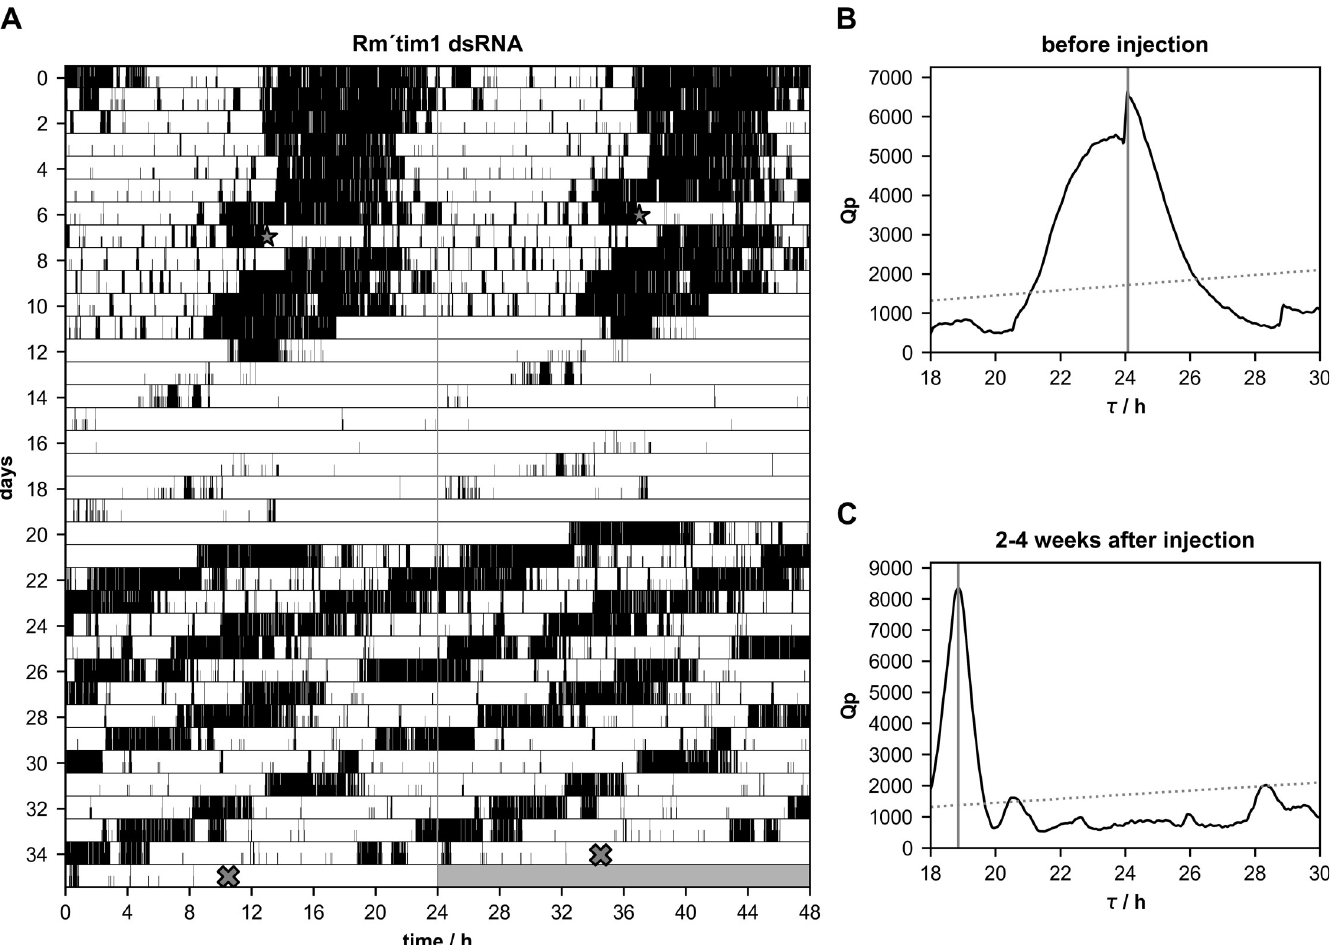
Fig 5. A-C. Injections of Rm´tim1 dsRNA significantly shortened the free-running period( τ ) of circadian locomotor activity rhythms (n = 8 of 10; p = 0.0016). (A) Double-plotted running wheel activity of a Madeira cockroach in constant darkness. Rm´tim1 dsRNA was injected at day 7 (star) of the recording. The injected cockroach retained synchronized circadian locomotor activity rhythms, but with a significantly shortened period. At day 35 of the locomotor activity recording the cockroach was sacrificed (cross) and qPCR was used to confirm the knockdown. Chi-square periodogram analysis of the activity shown in (A) , 1–7 days before dsRNA injection revealed a period of 24.08 h (B) and a period of 18.85 h 2–4 weeks after the injection (C)